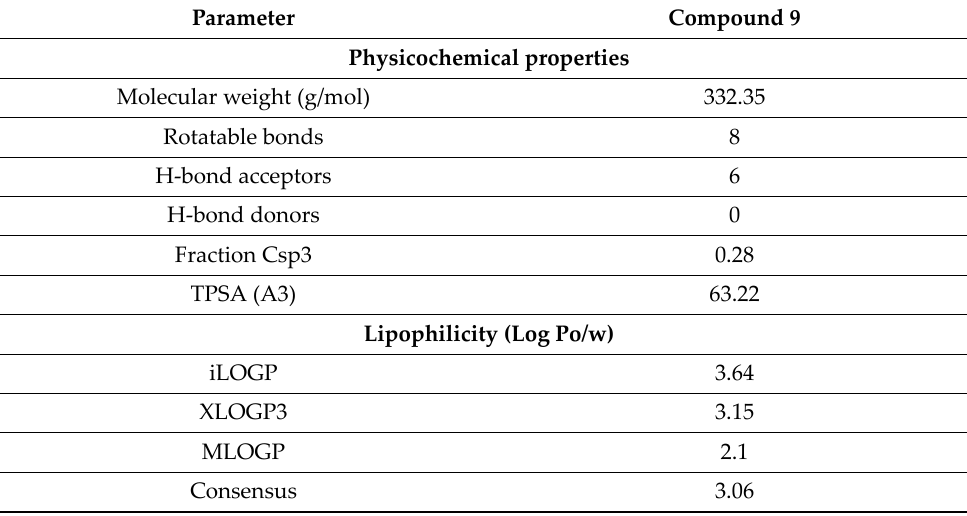
Table 5. Predicted ADMET properties of compound 9 .